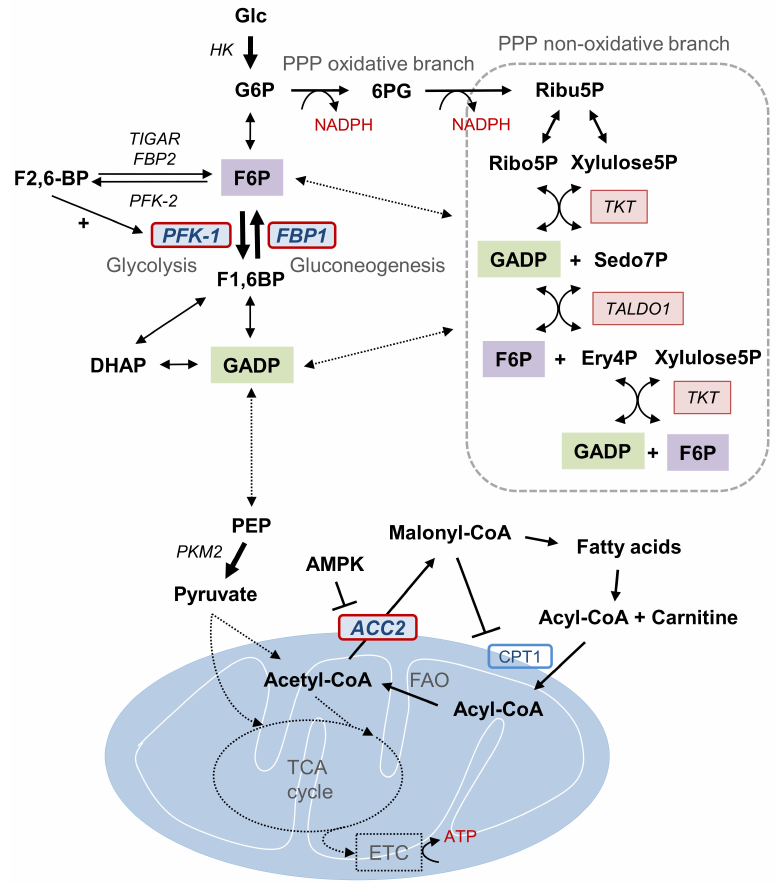
Figure 1. Metabolic pathways and Snail target enzymes of catabolic